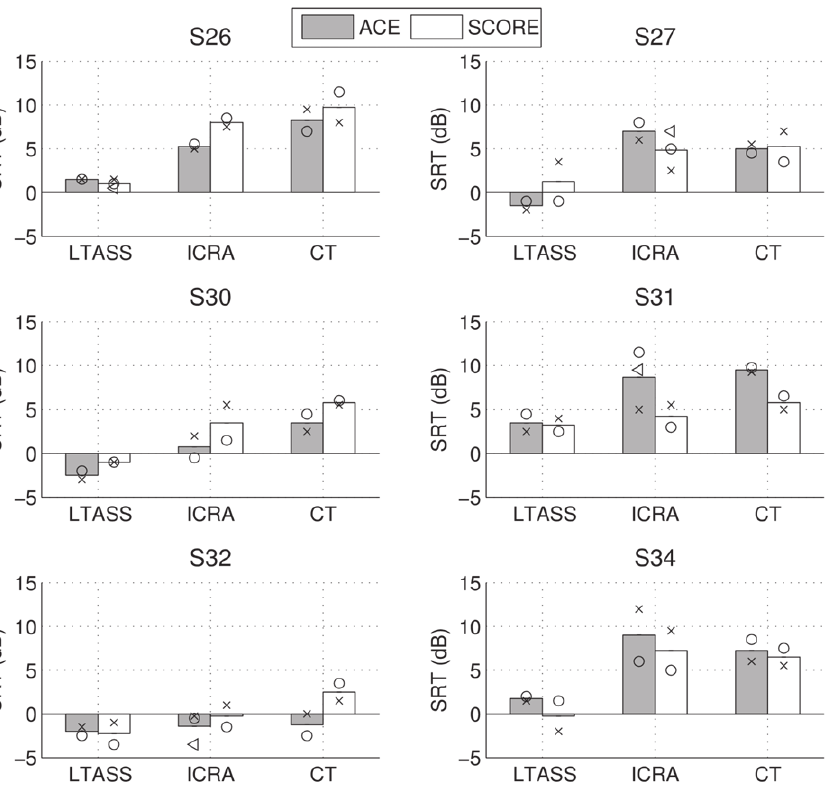
Figure 5. Speech in noise results for ACE and SCORE, for a steady state noise masker ( LTASS ) , fluctuating noise ( ICRA ) , and a competing talker ( CT ) , for each subject. The markers indicate SRTs calculated from a single list, and markers with the same symbols indicate results obtained during the same test session.